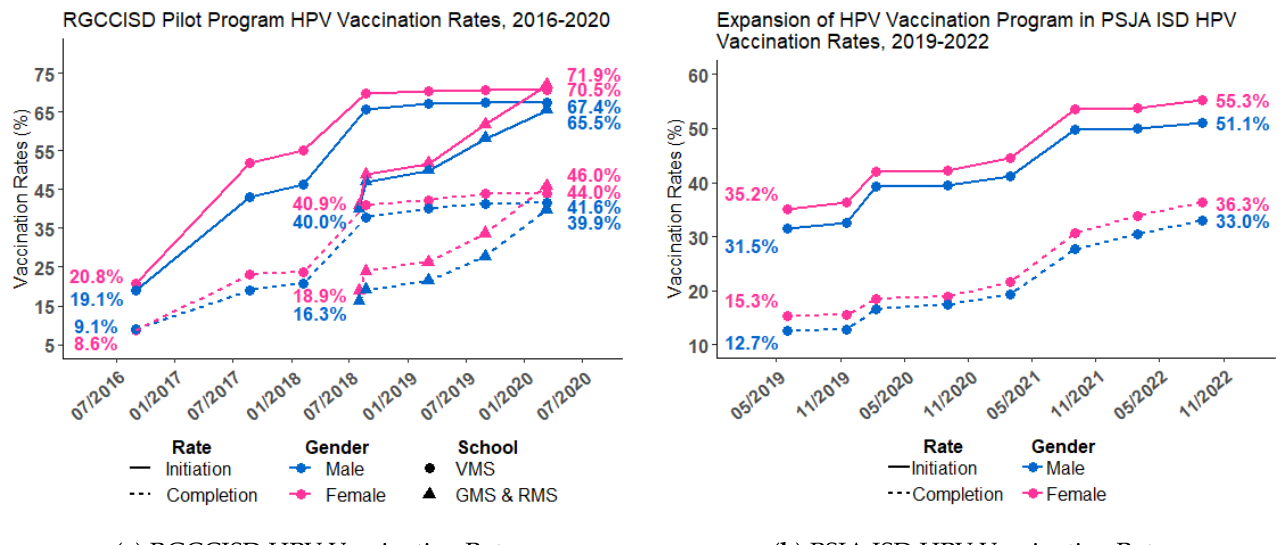
Figure 1. HPV vaccination rates in the RGCCISD pilot program and its expansion in PSJA ISD : ( a ) HPV vaccine initiation and HPV-UTD rates in the pilot program in RGCCISD from 2016–2020; ( b ) HPV vaccine initiation and HPV-UTD rates in the expansion in PSJA ISD.